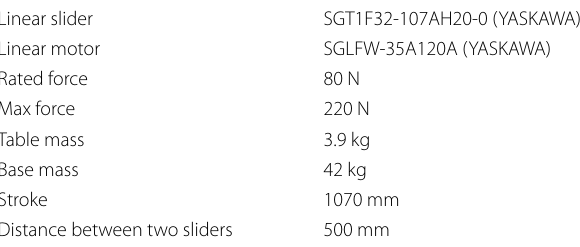
Table 1 Specifications of experimental equipment